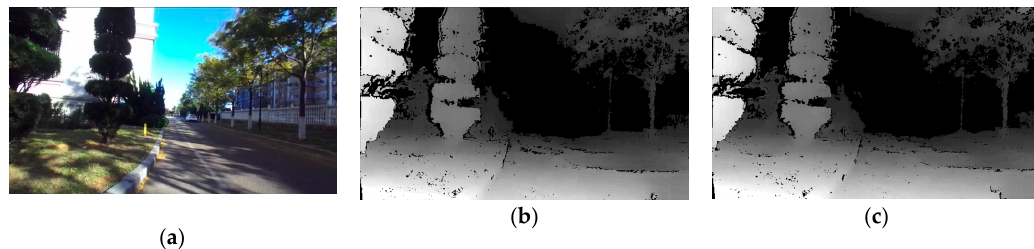
Figure 13. ( a ) The original image; ( b ) The depth map calculated using the parameters estimated by Zhang’s method; ( c ) The right depth map calculated using our estimated parameters.